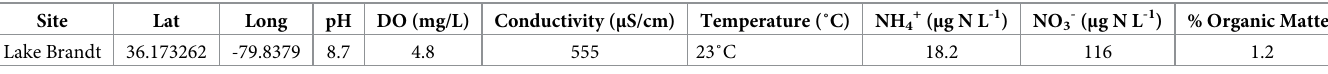
Table 1. Site data for surface water and sediment used in the study. Site